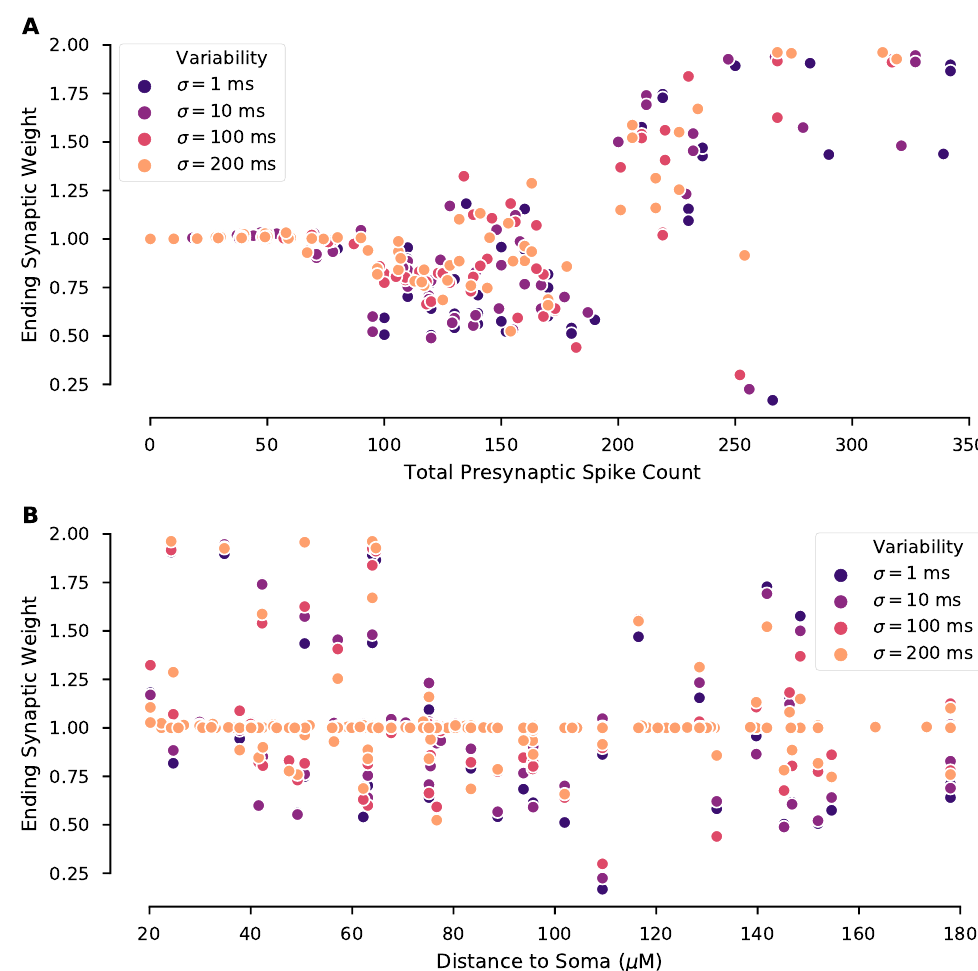
Figure 5. Ending synaptic weight is partially predicted by total pre-synaptic spike count per synapse. Ending synaptic weight of each synapse is plotted versus ( A ) its total pre-synaptic spike count across all 10 repeated trials and ( B ) distance of the synapse from the soma, with experiments separated by the level of trial-to-trial variability. ( A ) Ending weight exhibits no change for low spike counts, tends toward depression for intermediate spike counts, and exhibits potentiation for high spike counts. This trend is consistent regardless of trial-to-trial variability; however, for intermediate spike counts the ending weight is highly variable. ( B ) Correlation between ending synaptic weight and distance to soma is not significant for σ = 100 ms (R = − 0.23, p = 0.07) or 200 ms (R = − 0.21, p = 0.11), but is significant for σ = 1 ms (R = − 0.25, p = 0.04) and 10 ms (R = − 0.25, p =